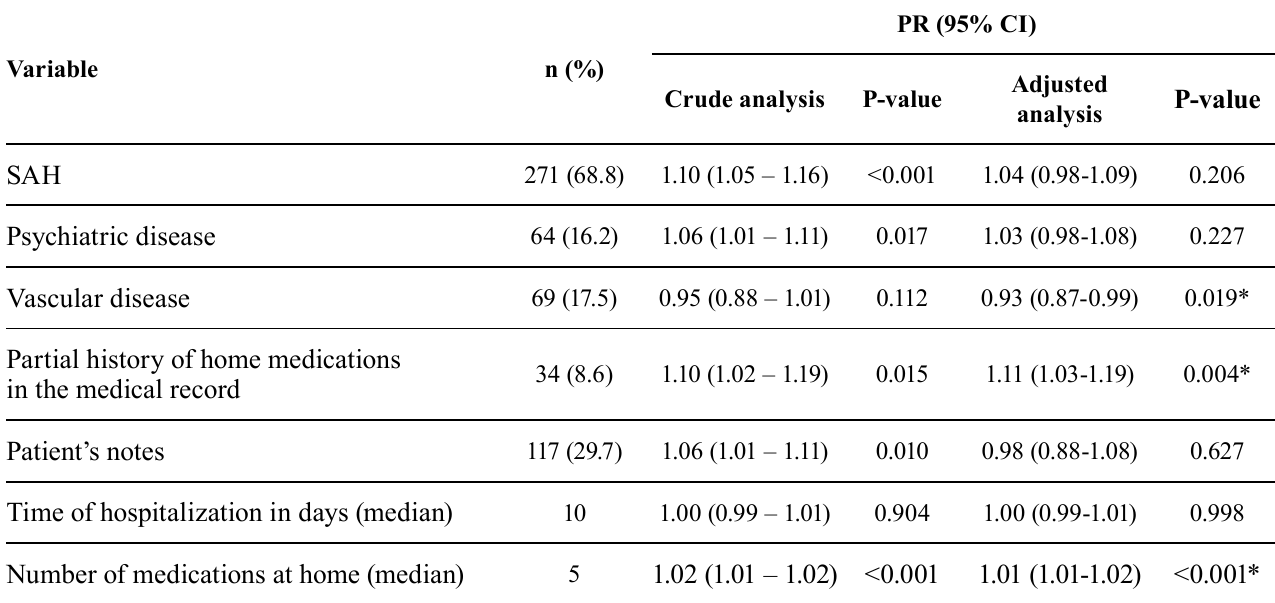
TABLE III – Crude and adjusted analysis of the independent variables related to the occurrence of drug discrepancy among the study participants hospitalized in the surveyed hospital, 2015-2016